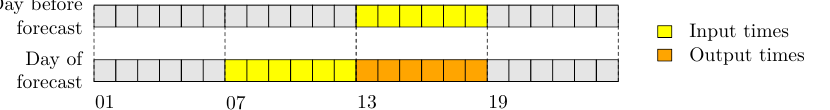
Figure 3. One sample of observation data. Historical observations are observations from the input times, shown here in yellow. The NWP data are forecast data valid in the output times, here shown in